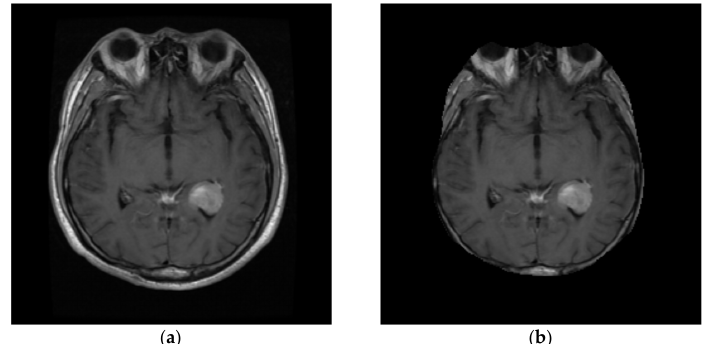
Figure 9. Pre ‐ processing step: ( a ) original brain image; ( b ) brain image after pre ‐ processing. Figure 9. Pre-processing step: ( a ) original brain image; ( b ) brain image after